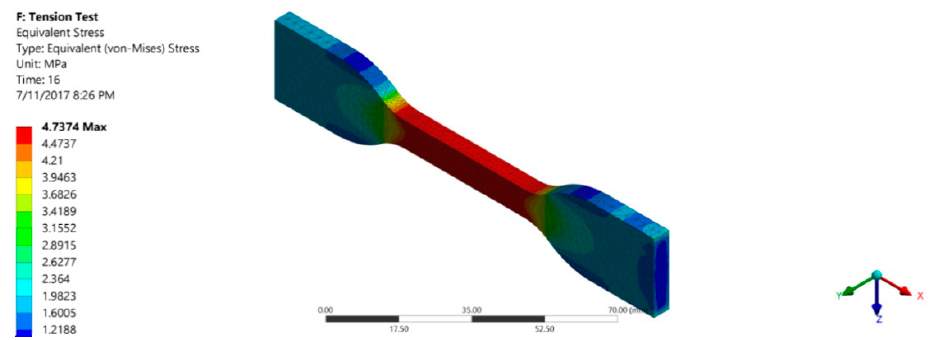
Figure 7. Isometric view of sample in simulation showing tensile stress in tension test.